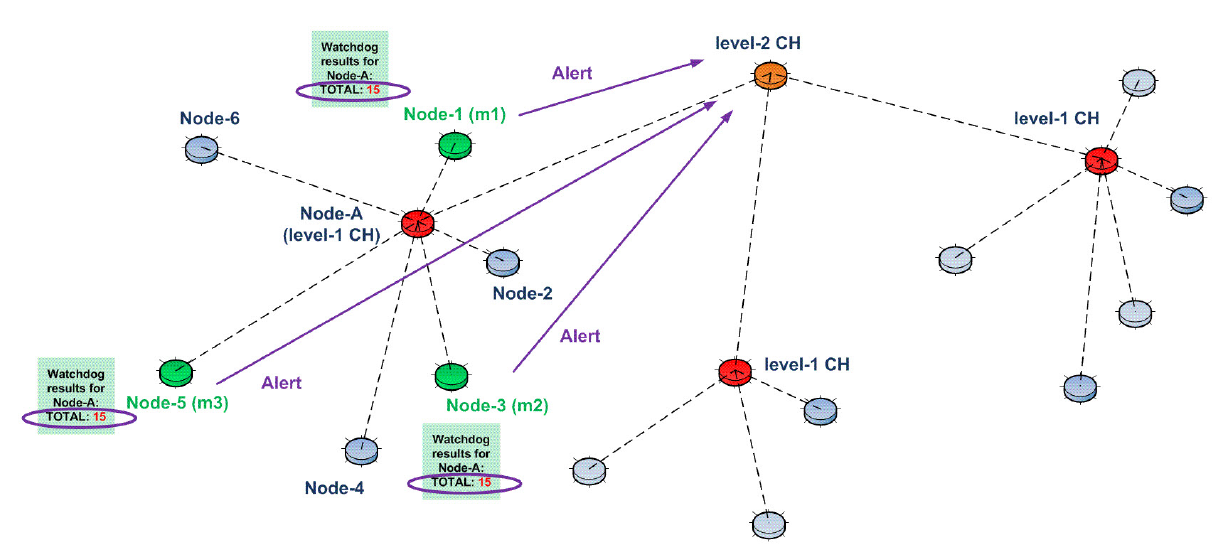
Figure 8. Alert propagation towards upper levels in our